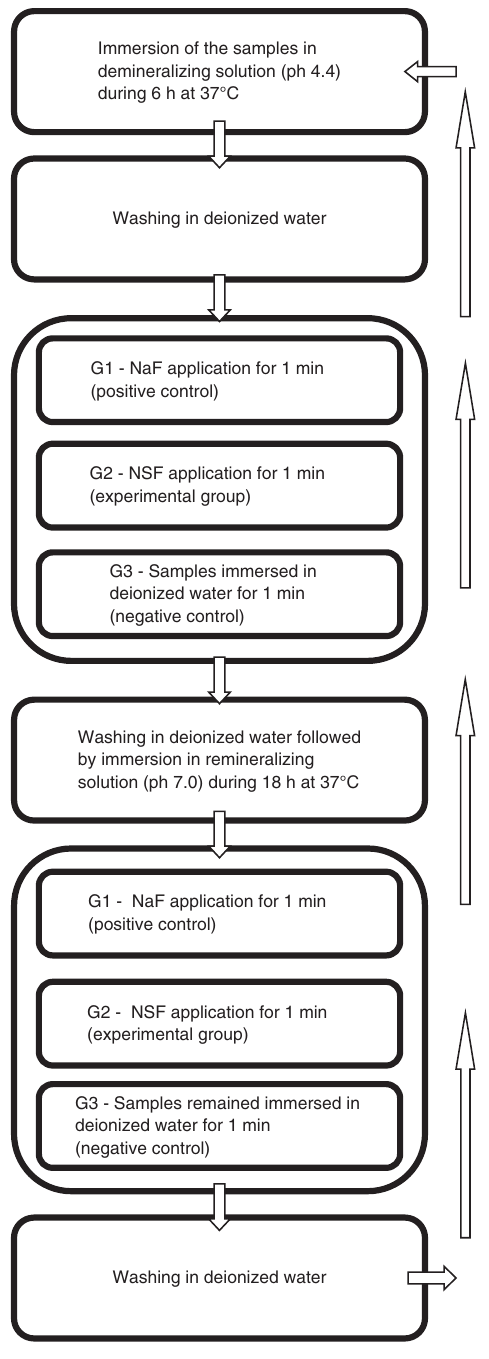
Figure 2: Routine for 24-h pH cycling stages, repeated for 14